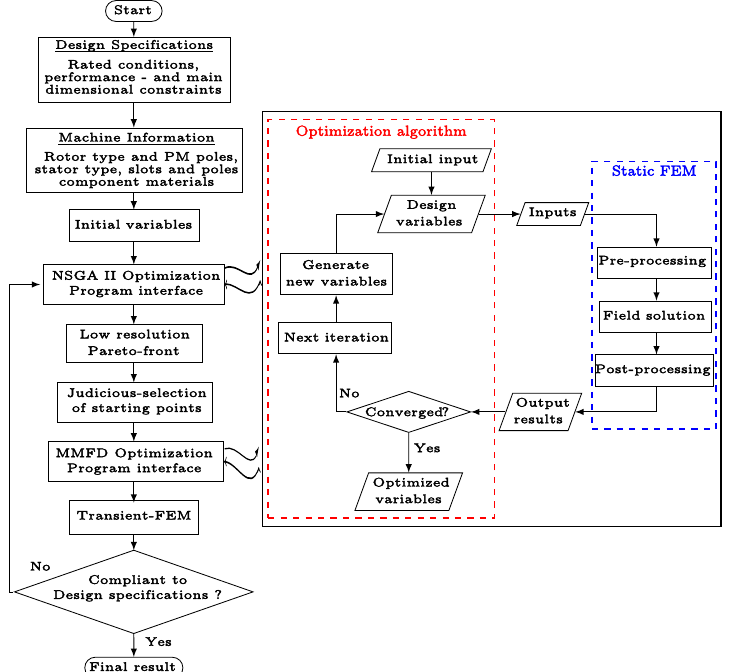
Figure 11. Hybrid optimization technique workflow.